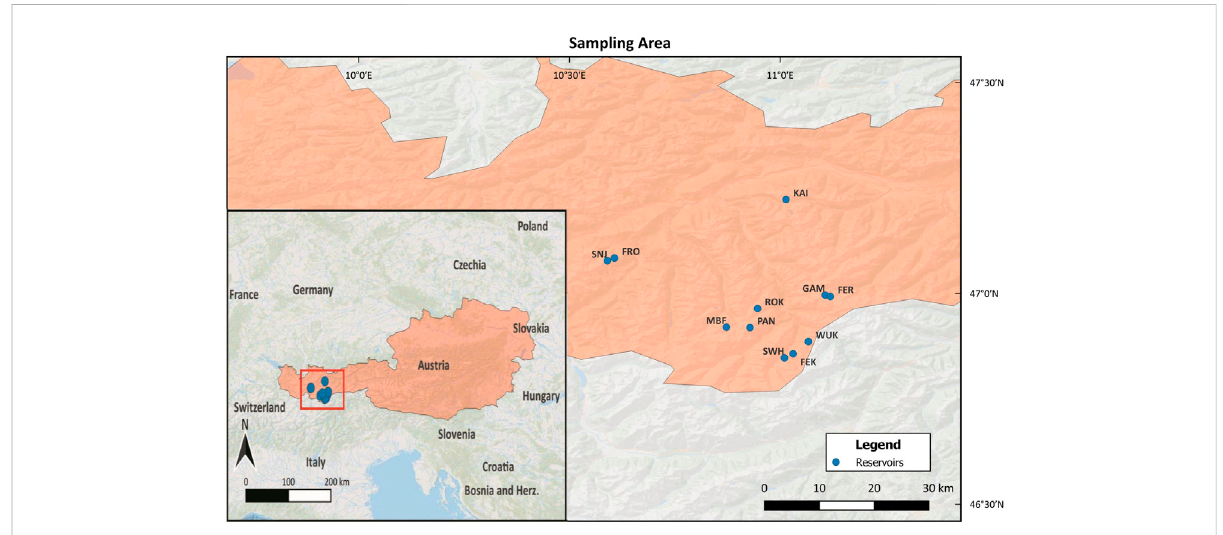
FIGURE 1 Map of the sampling area. Blue dots indicate sampling sites. For reservoir codes see Table